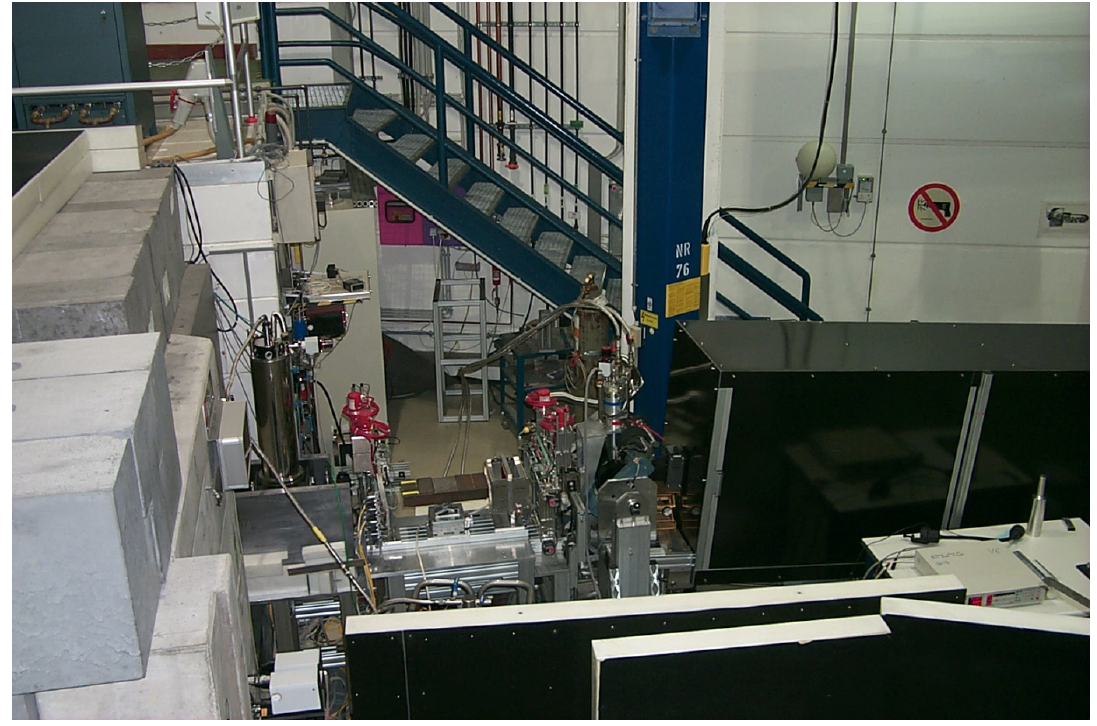
Figure 1: View of